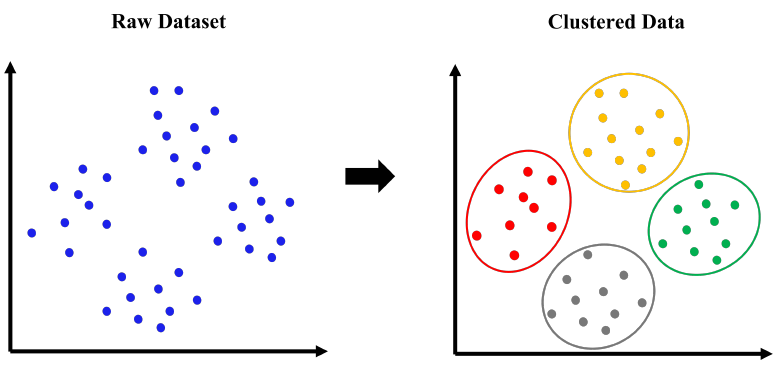
Figure 4. K-means